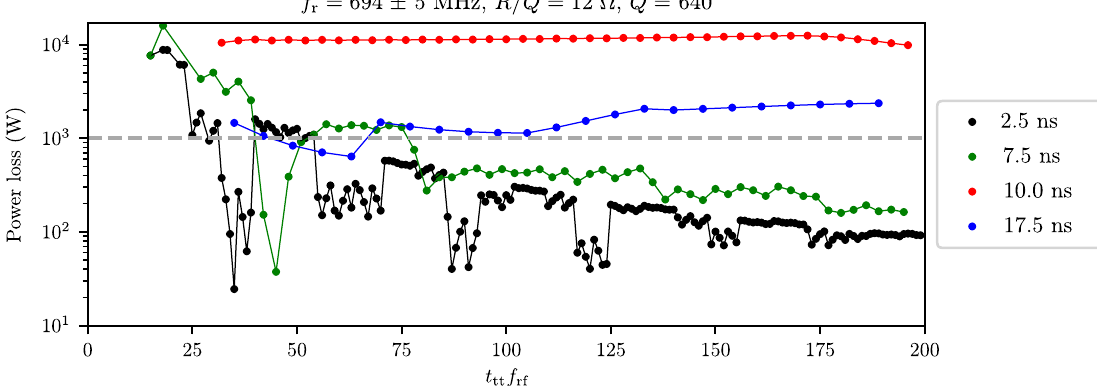
FIG. 18. Dependence of the maximum power loss in resonant cases on the train spacing for the parameters of the Z machine and different bunch spacings. The horizontal line shows the limit of 1 kW. For bunch spacings t ¼ 2 . 5 ns (the black dots) and the power losses are below the values corresponding to t losses is similar to t bb